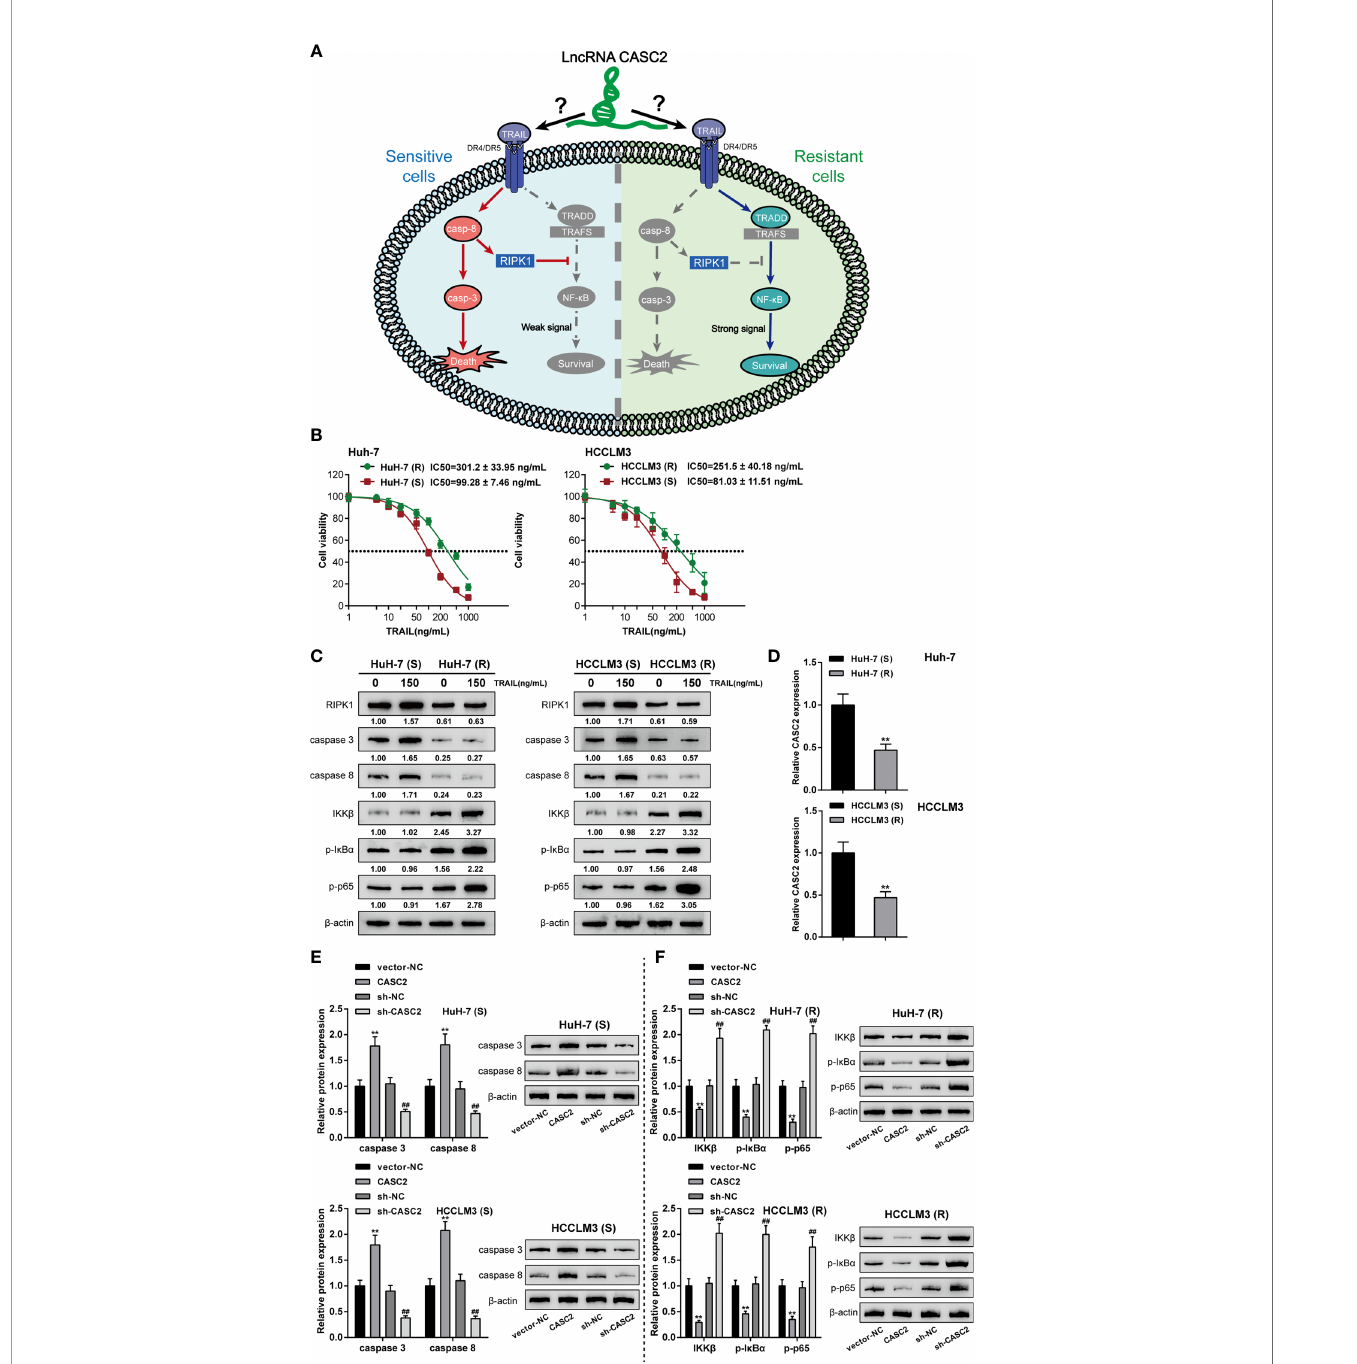
FIGURE 3 | Effects of lncRNA CASC2 on caspase-cascades and the NF- k B pathway. (A) A schematic diagram showing two different modes of TRAIL acting on TRAIL-sensitive and TRAIL-resistant cell lines. (B) Huh-7 and HCCLM3 cells were exposed to 1, 10, 100, and 1,000 ng/ml rhTRAIL protein and examined for the cell viability by MTT assay. The IC50 values were calculated and shown. Regular Huh-7 and HCCLM3 cells were then divided into TRAIL-sensitive Huh-7 (S) and HCCLM3 (S) and TRAIL-resistant Huh-7 (R) and HCCLM3 (R). (C) Huh-7 (S), HCCLM3 (S), Huh-7 (R), and HCCLM3 (R) cells were treated with 0 or 150 ng/ml rhTRAIL and examined for the protein levels of RIPK1, caspase-8, caspase-3, IKK b , p-I k B a , and p-p65 using Immunoblotting. (D) CASC2 expression was determined in Huh-7 (S), HCCLM3 (S), Huh-7 (R), and HCCLM3 (R) cells using qRT-PCR. (E) Huh-7 (S) and HCCLM3 (S) cells were transfected with CASC2 or sh- CASC2 and examined for the protein levels of caspase-8 and caspase-3 using Immunoblotting. (F) Huh-7 (R) and HCCLM3 (R) cells were transfected with CASC2 or sh-CASC2 and examined for the protein levels of IKK b , p-I k B a , and p-p65 using Immunoblotting. **p < 0.01, compared with sensitive group or vector-NC group, ## p < 0.01, compared with sh-NC